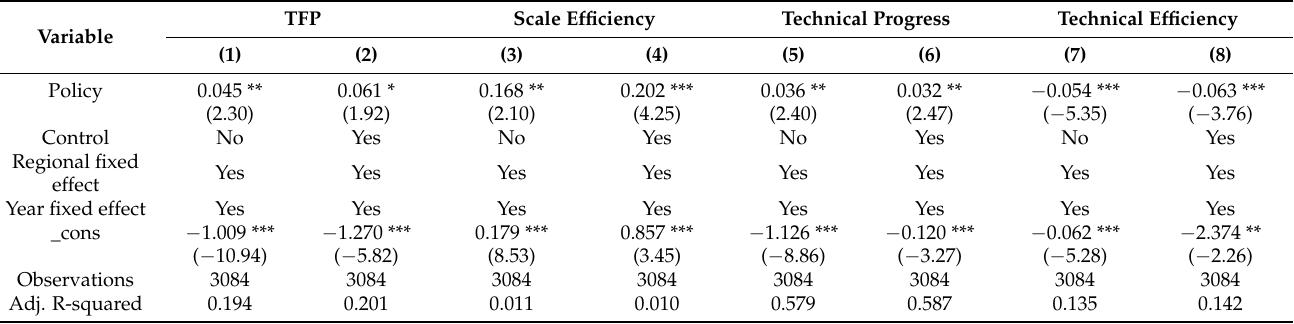
Table 6. Reselected experimental and control